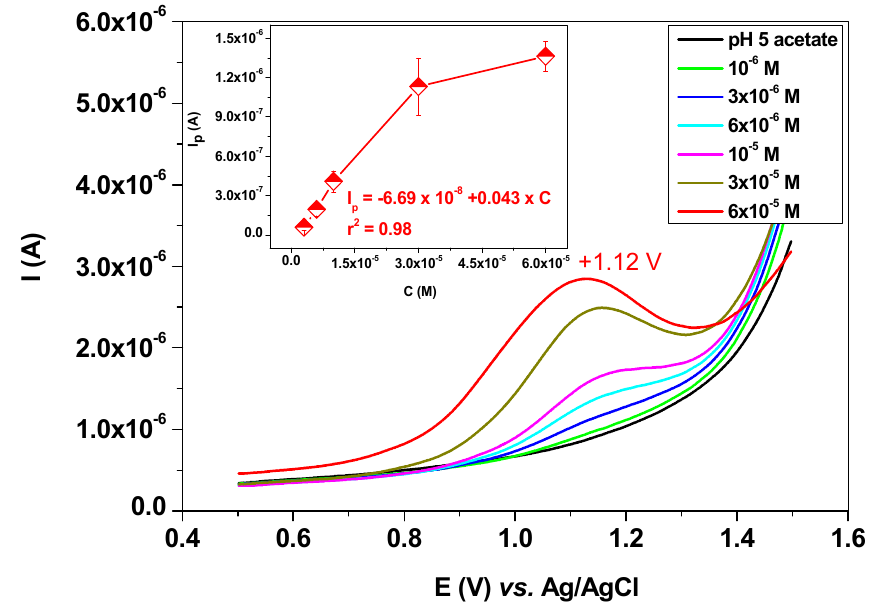
Figure 8. DPV recorded in supporting electrolyte of pH 5 containing various concentrations of AZT, from 10 − 6 to 6 × 10 − 5 M; inset : variation of peak current, I p , with the solution concentration, C.